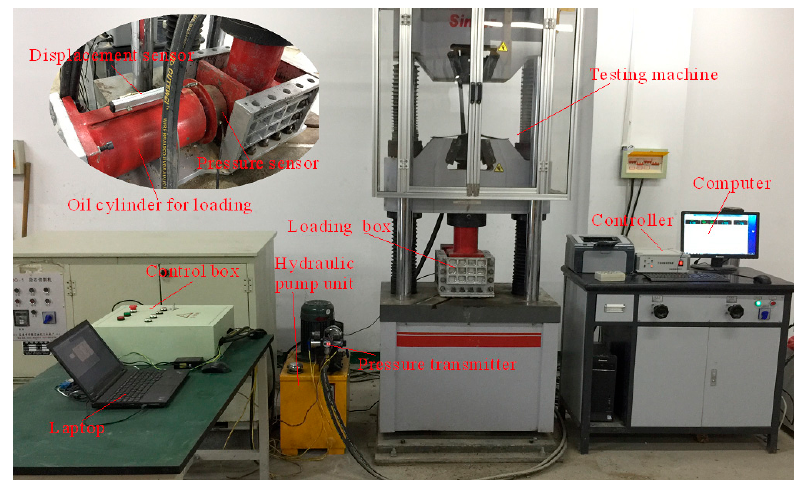
Figure 5. T he bidirectional loading test system. Figure 5. The bidirectional loading test